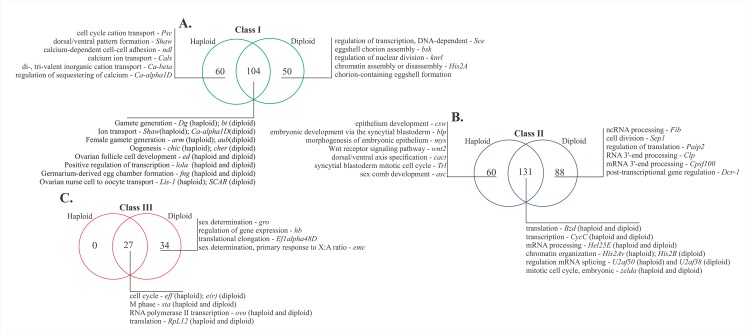
Gene Ontology analysis.The main biological processes found for class I (A), class II (B) and class III (C) genes. The exclusive biological processes and those shared between the haploid and diploid embryos in each class of mRNAs are highlighted according to their specificity in embryogenesis (for the complete GO terms, refer to S6 Table).